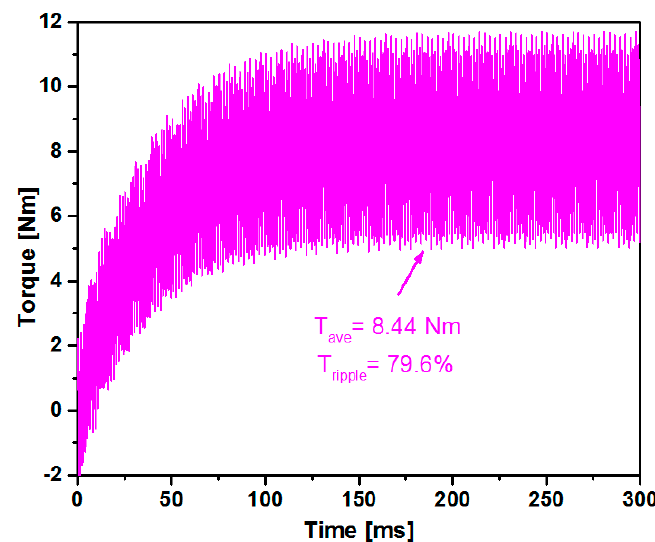
Figure 7. Torque of the BL ‐ WRSM (basic model).